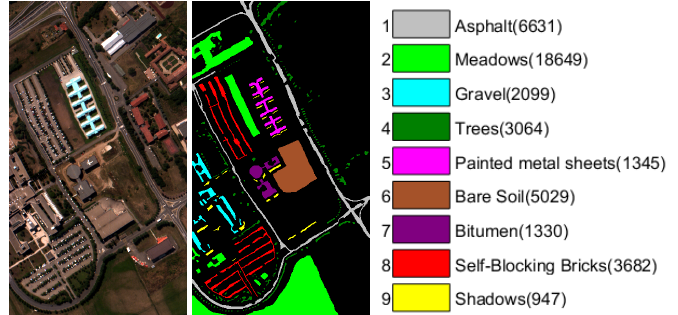
Figure 3. The false color composition and ground truth of University of Pavia data with numbers of samples for each class in brackets.